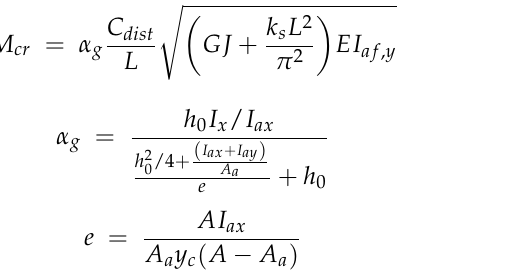
Table 3. C dist coefficient for continuous beams with loading on the analyzed span ( L ). Adapted from ABNT NBR 8800:2008 [108].